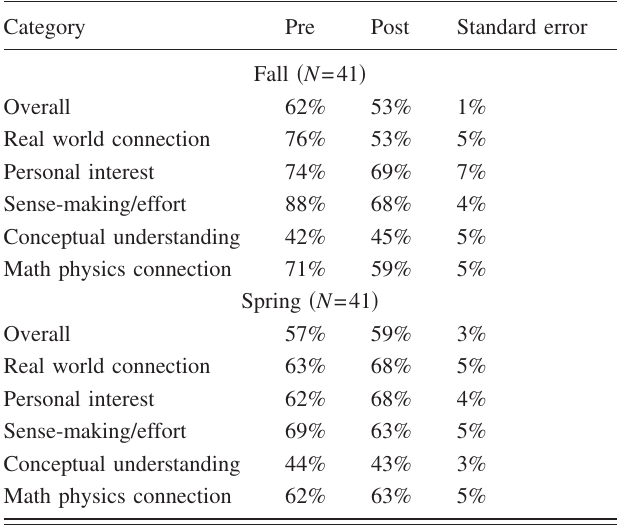
TABLE V. Physics I vs Physics II; 2003–2004 calculus-based course at MMSU with same instructor and students. These results are using V.2 of the survey so the categories are slightly different from those seen with V.3 throughout the rest of this paper.